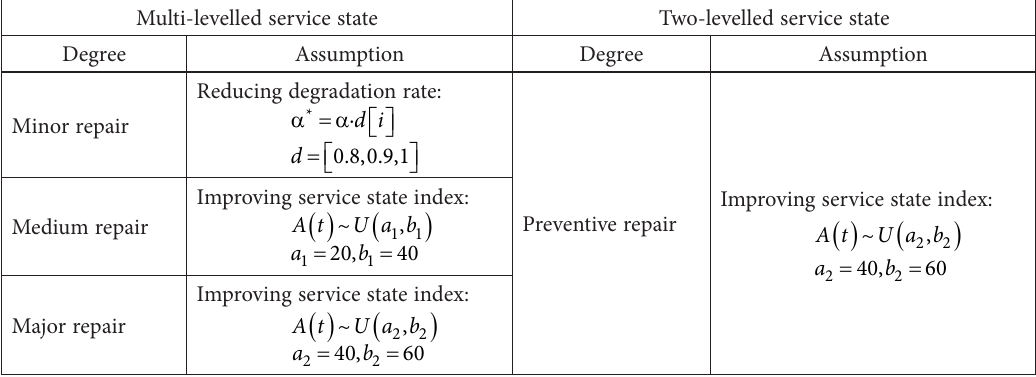
Table 5. Assumptions of different degrees of repairing measures